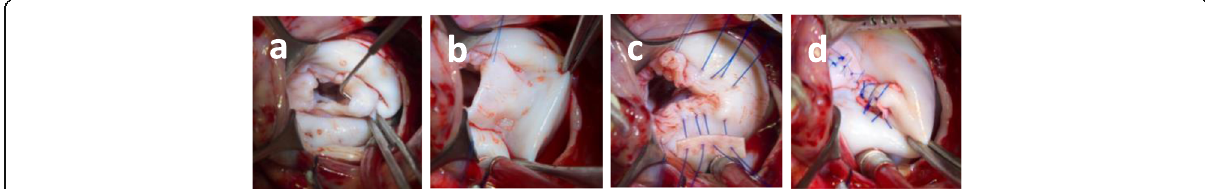
Fig. 5 Mitral valvuloplasty, surgeon ’ s view: a Redundant mitral valve. P2 segment prolapse. b Quadrangular P2 resection of the mitral valve. c Annuloplasty with bovine pericardium patch. d Annuloplasty with valvuloplasty, final result